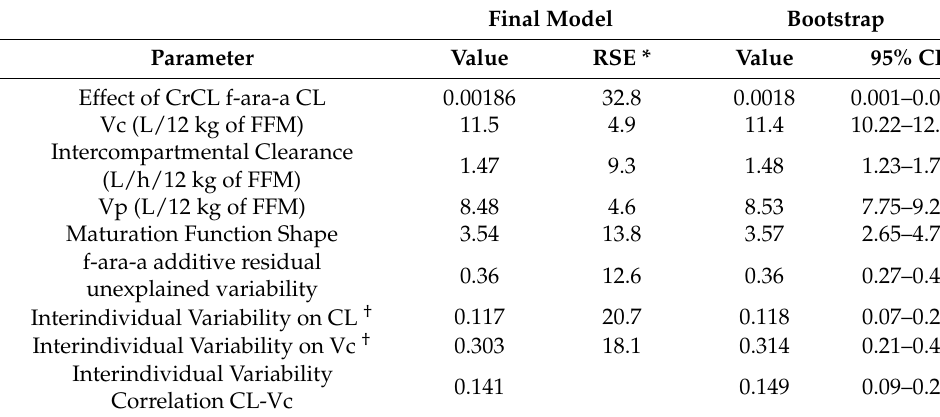
Figure 4. Simulated cAUC values to compare doses assigned by the refined model and the original model. ( a ) Predicted cAUCs of individuals less than 2 years old separated by which model was